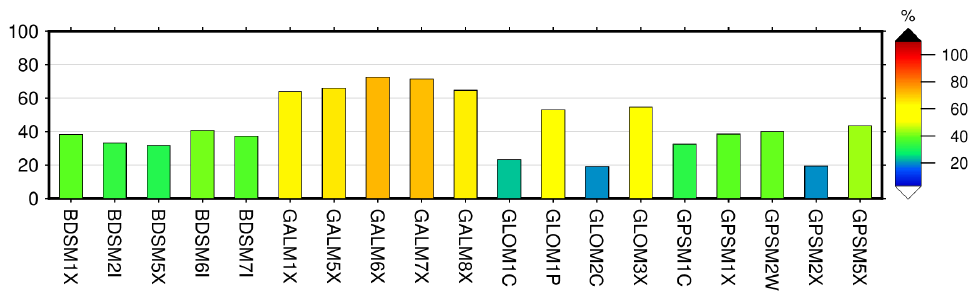
Figure 6. Improvement of pseudorange (Code) multipath estimated for all possible linear combina- tions as observed at station KBG1 with Eccosorb with respect to KBG2 without Eccosorb averaged over the period January–May